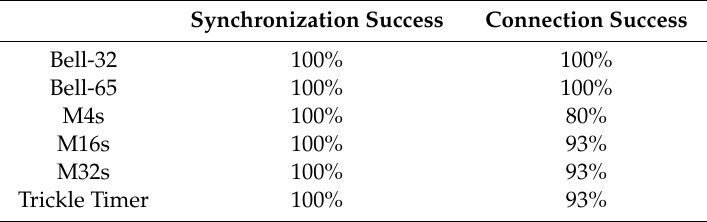
Table 7. Probability of synchronization / connection success.